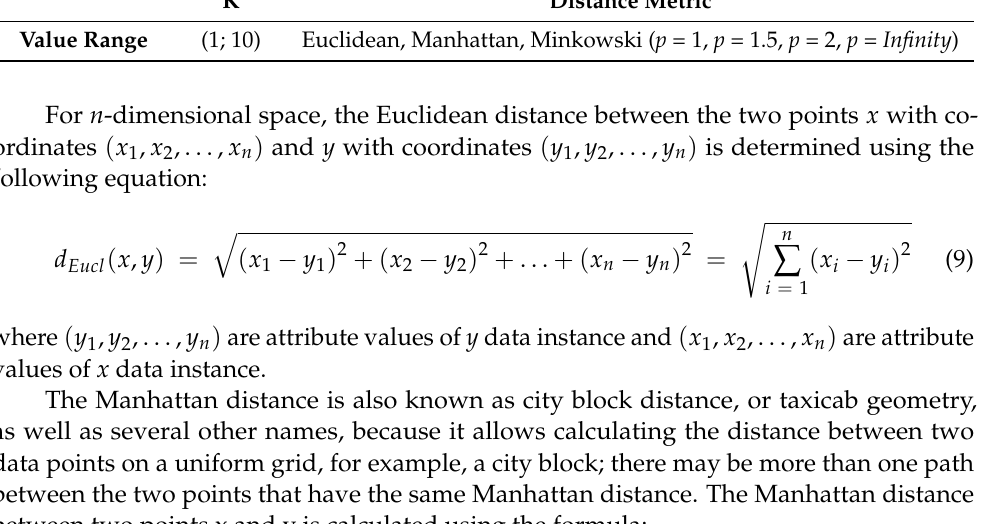
Figure 16. Testing data results of the DT model.